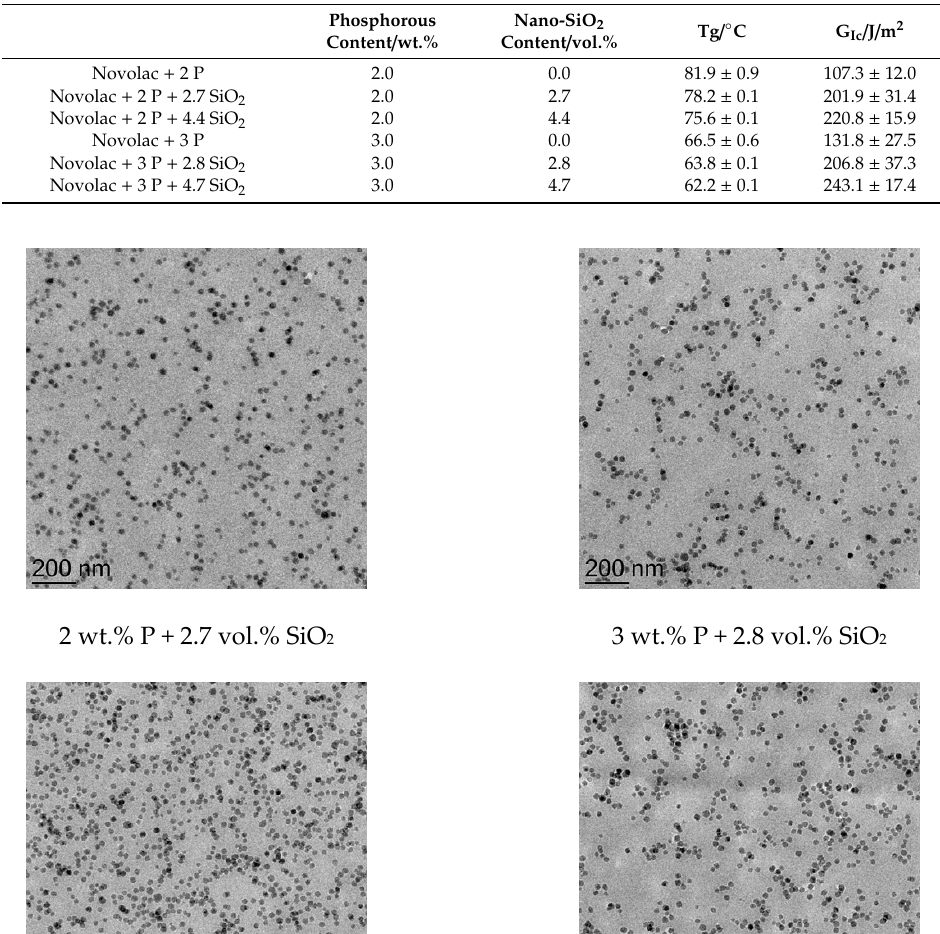
Table 5. Adjusted silica content, glass transition temperature and fracture toughness of DOPO and nano-SiO 2 modified epoxy resin.